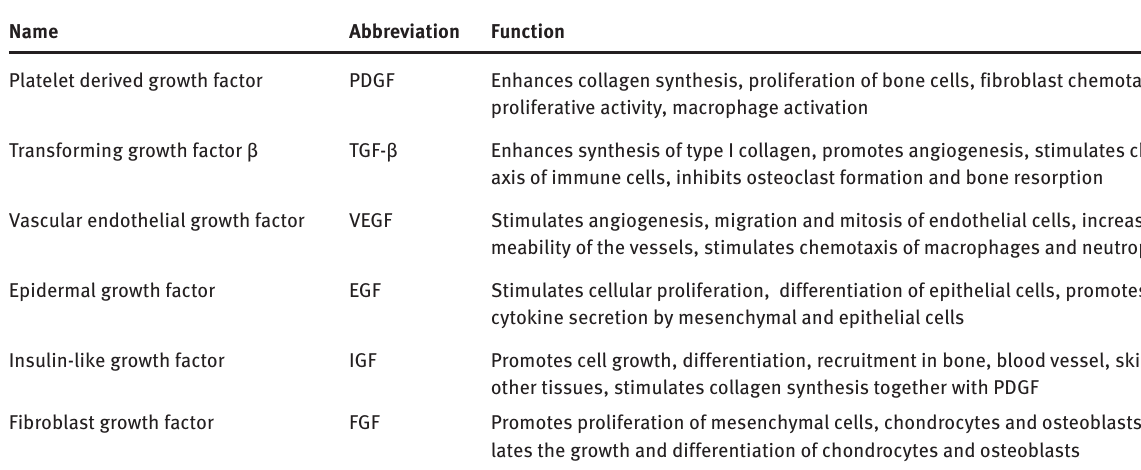
Table 2: Growth factors in PRP and their biological